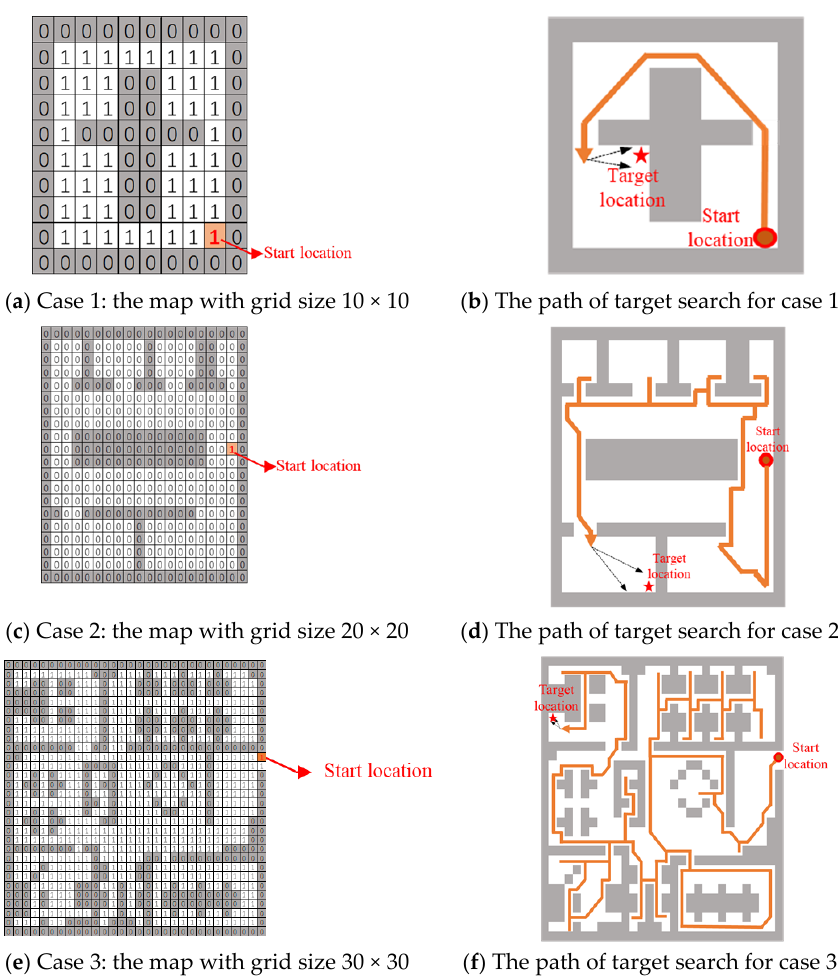
Figure 8. Generated path of target search for 3 cases.